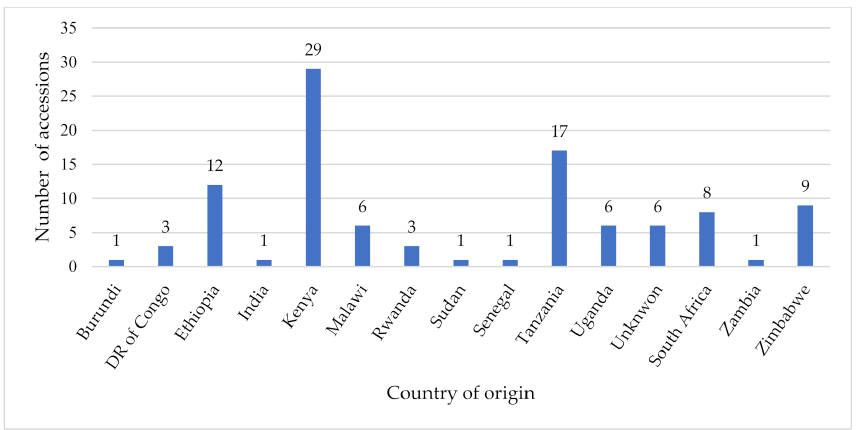
Figure 1. Rhodes grass accessions assessed by country of